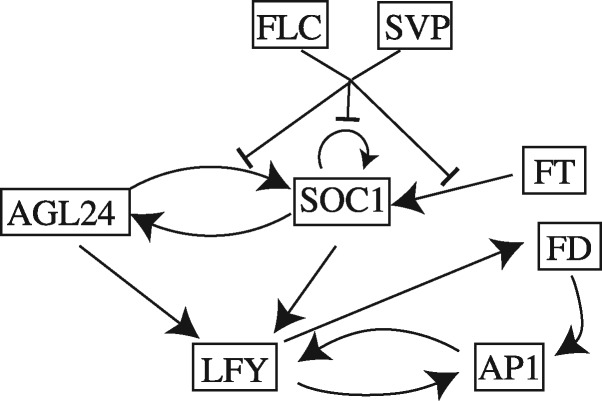
Diagram of the flowering time of A. thaliana system (Leal Valentim et al., 2015)